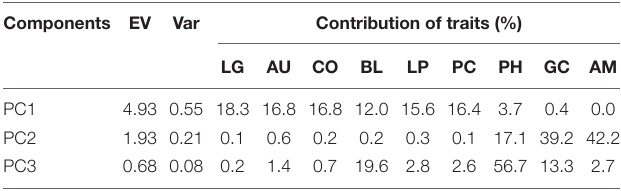
TABLE 3 | Principal components extracted from the most influential phenotypic traits among the aromatic rice germplasm of Manipur. Components EV Var